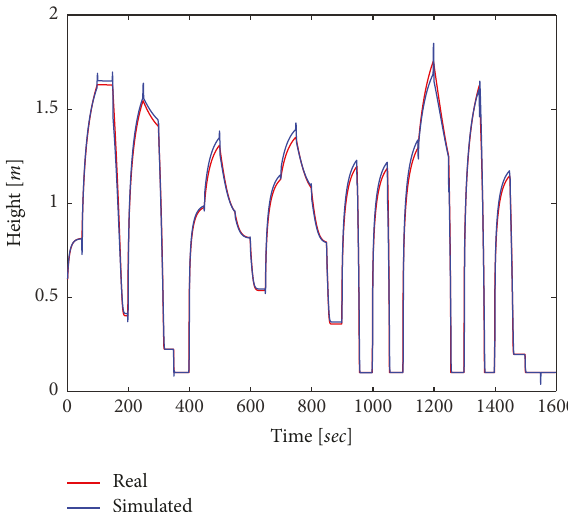
Figure 14: Result of the identification process in open loop.